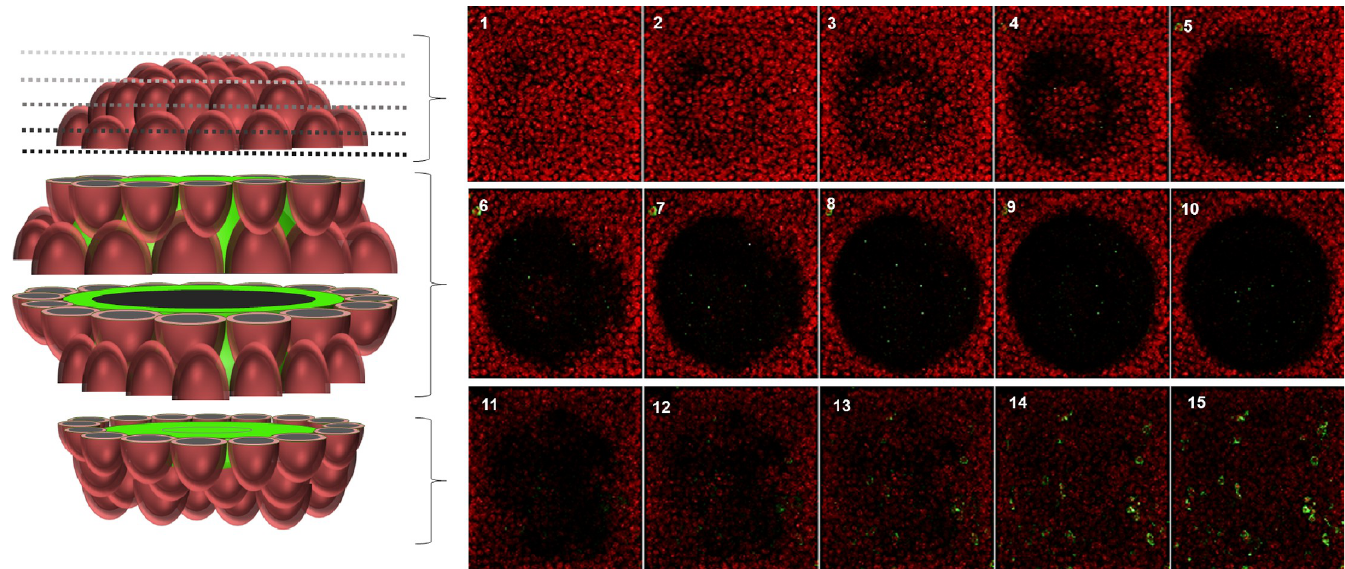
Fig 3. Cumulus oocyte complex in a sequence of confocal Z-stack images. Images of COC co-incubated with BHV1 for 24 h in a series of focal planes (step size of 1 μ m) evidencing the presence of BHV1 (green) inside the oocyte.